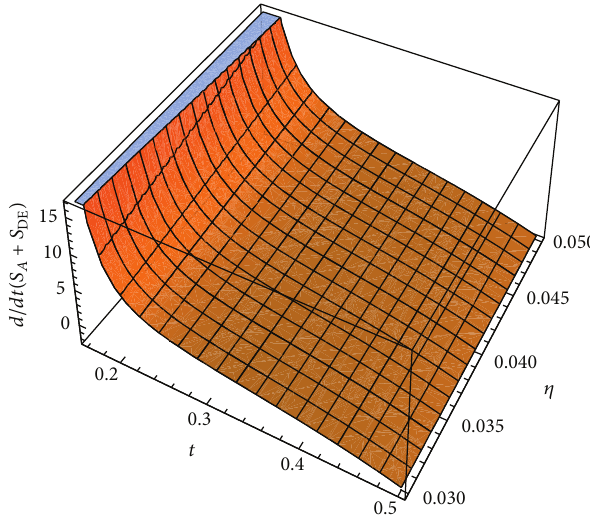
Figure 10: Plot of time evolution of total entropy ( on (47). The {𝛼,𝛽} combination is taken as {0.9735, 0.3701} and 𝜂 ranges from 0.0002 to 0.0005.